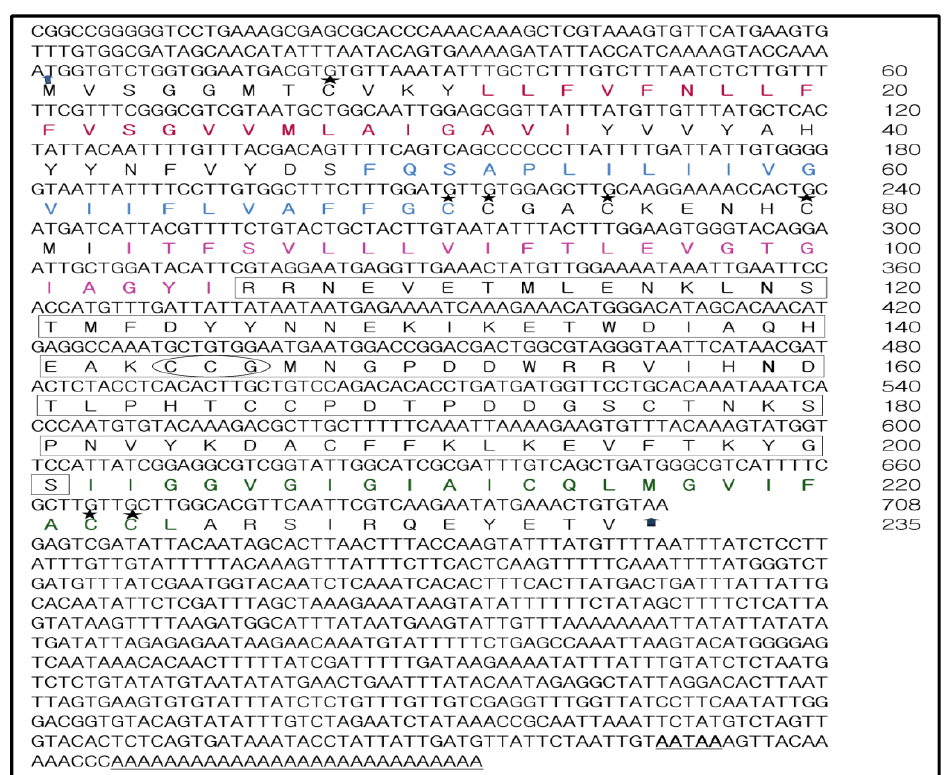
Figure 1. Nucleotide and deduced amino acid sequence of cDNA encoding TmCD63. Deduced amino acids are denoted as a one-letter code, arrows indicate initiation codon and the translation stop codon. The poly-A signal in 3'-UTR is bold and underlined, whereas the poly-A tail is underlined. The conserved TM regions 1–4 are represented in red, blue, pink and green respectively. The large extracellular loop (LEL) is boxed and contains the conserved “Cys-Cys-Gly” motif (encircled). The predicted palmitoylation cysteines are indicated in five-point star format and predicted N -glycosylation arginine residues are indicated in